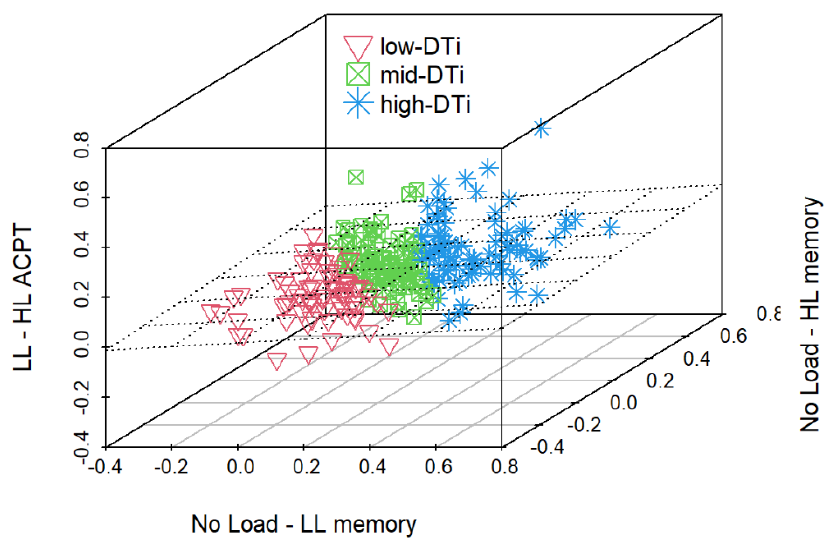
Figure 7. Graphical representation of participant dissimilarity calculated with a k-medoids clustering algorithm over three cost indices: the two cost indices from the memory test (No Load minus LL or HL for memory DTi) and the cost index from the ACPT (LL–HL for ACPT DTi). The cluster with low DTi includes 77 participants, the cluster with mid-DTi 88, and the cluster with high DTi 87. The rank comparison revealed no significant differences between the median ages of the three clusters of participants (Chisq = 1.945, df = 2, p -value = 0.378). In contrast, the differences between the auto-GEMS scores (Chisq = 8.158, df = 2, p -value = 0.017) and Education scores were significant (Chisq = 6.035, df = 2, p -value = 0.049). For the auto-GEMS scores, the high-DTi subgroup had significantly lower scores than both the mid-Dti (mean.rank.diff = 19.809, W = 4474, p = 0.04) and the low-DTi subgroups (mean.rank.diff = 32.057, W= 4157.5, p = 0.012). There was no difference between mid-Dti and low-Dti (mean.rank.diff = 12.247, W = 3761.5, p = 0.111) subgroups. Auto-GEMS scores for each cluster are shown in Figure 8.